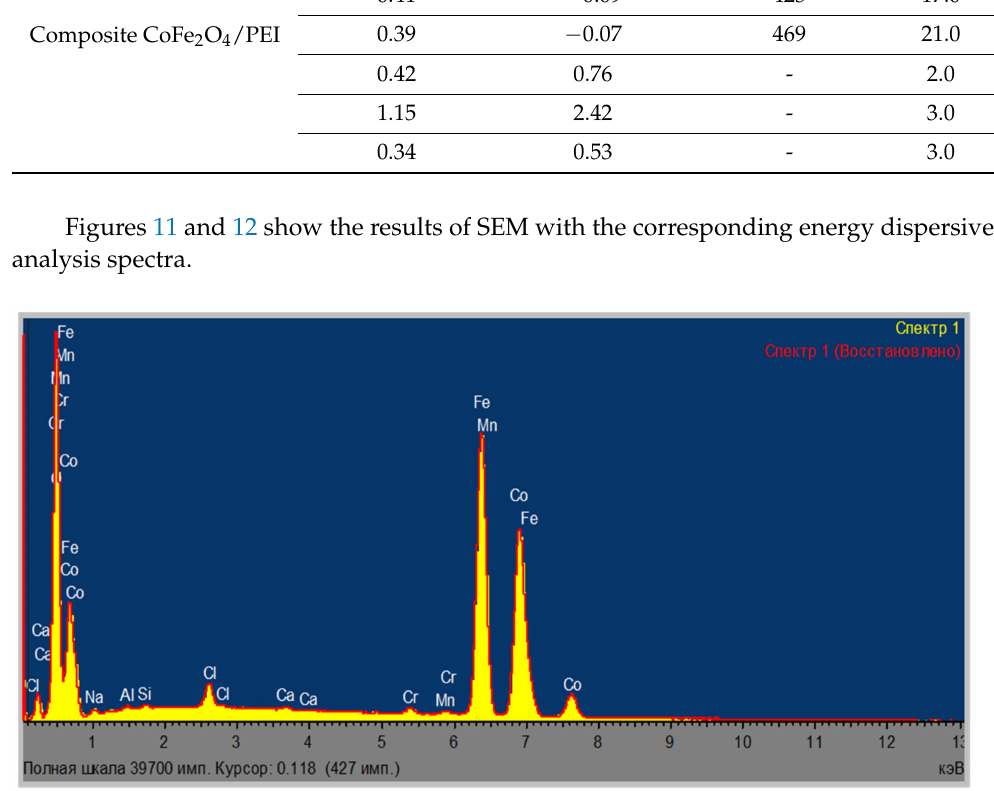
Figure 11. X-ray fluorescence spectrum of CoFe 2 O 4 . The full scale of 39,700 pulses. The cursor is 0.118 (427